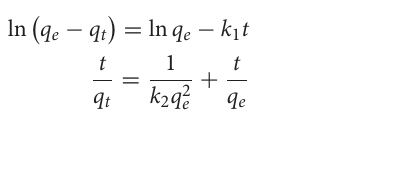
TABLE 2 | Intraparticle diffusion model parameters for the adsorption of iodine over JLUE-COP-3. C 0 (mg/L)